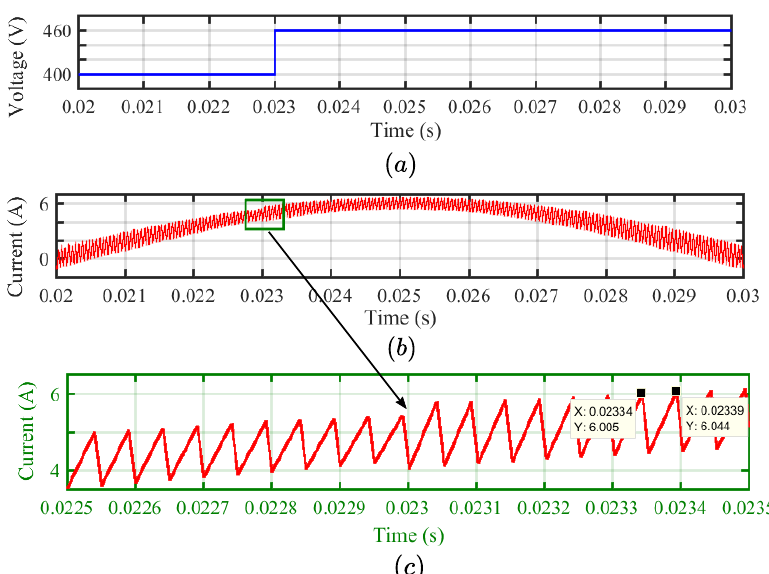
Figure 17. ( a ) Step rise in the supply voltage. ( b ) Inductor current waveform over a half cycle. ( c ) Inductor current waveform zoomed around the step change.